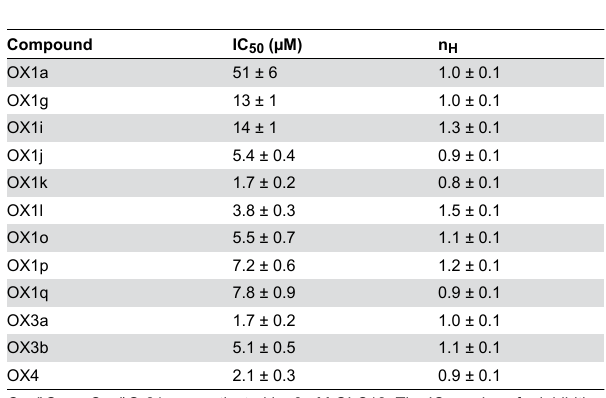
and n values for Orco 50 H